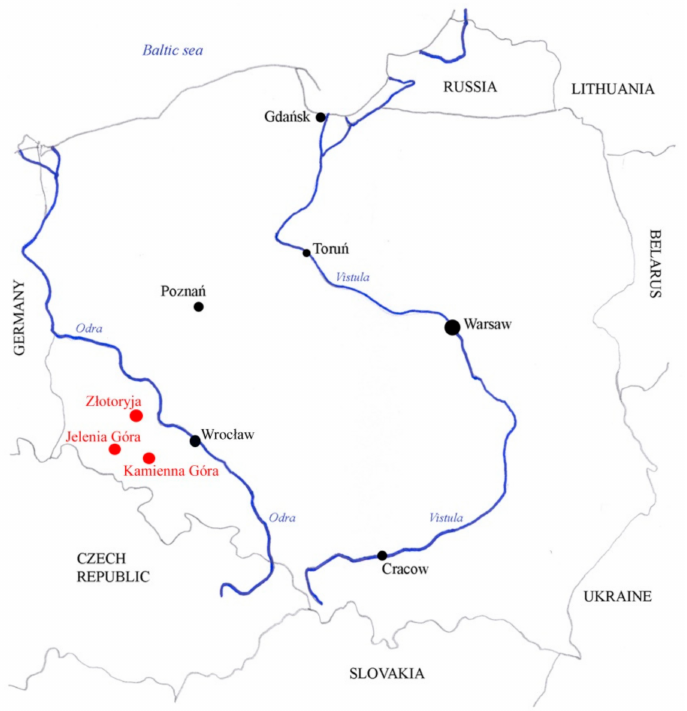
Figure 1. Locations of archaeological sites (red points). Map presents main cities (black points) and main rivers (blue lines) by A. Chr ó szcz.